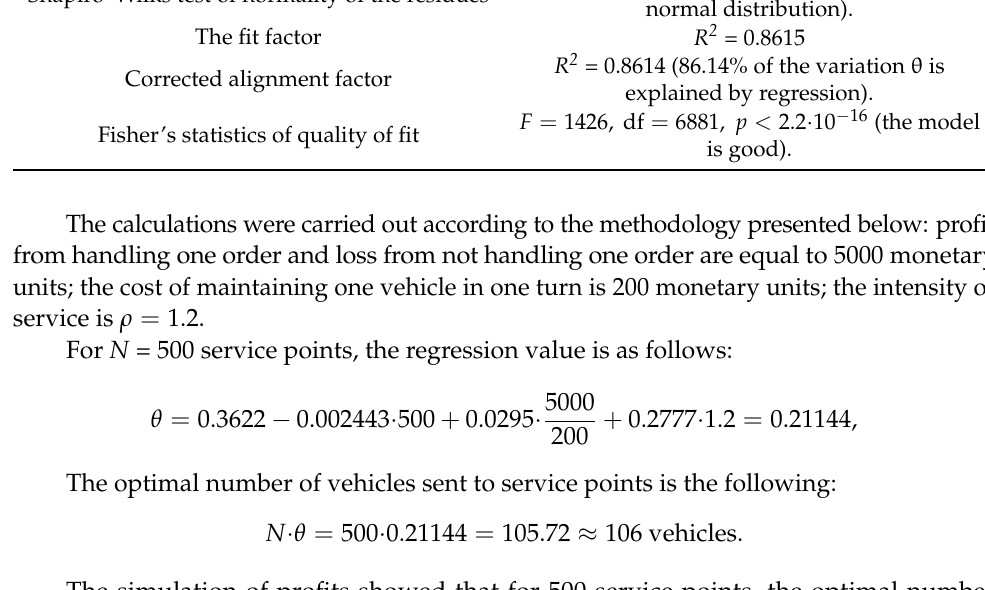
Table 1. The regression evaluation. Parameter Standard deviation res. σ = 0.05234 t p < 2.2 · 10 − 16 (the residues do not have a Shapiro–Wilks test of normality of the residues normal distribution). The fit factor R 2 = 0.8615 R 2 = 0.8614 (86.14% of the variation θ is Corrected alignment factor explained by regression). F = 1426, df = 6881, p < 2.2 · 10 − 16 (the model Fisher’s statistics of quality of fit is